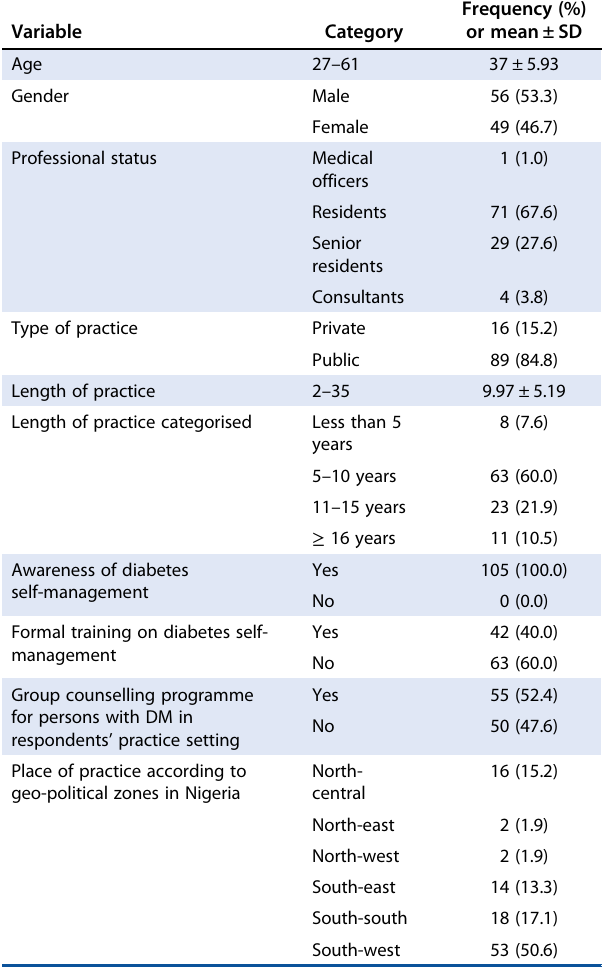
Table 1: General characteristics of respondents